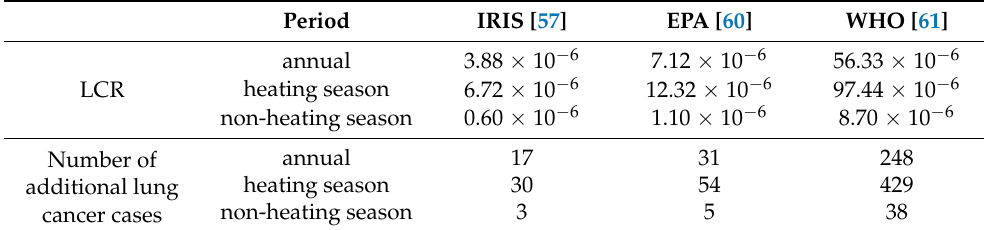
Table 6. Lifetime cancer risk and number of additional lung cancer cases due to exposure to long-term average (2018–2021) concentrations of B[a]P (ng · m − 3 ) in the Silesian Voivodeship according to IRIS, EPA and